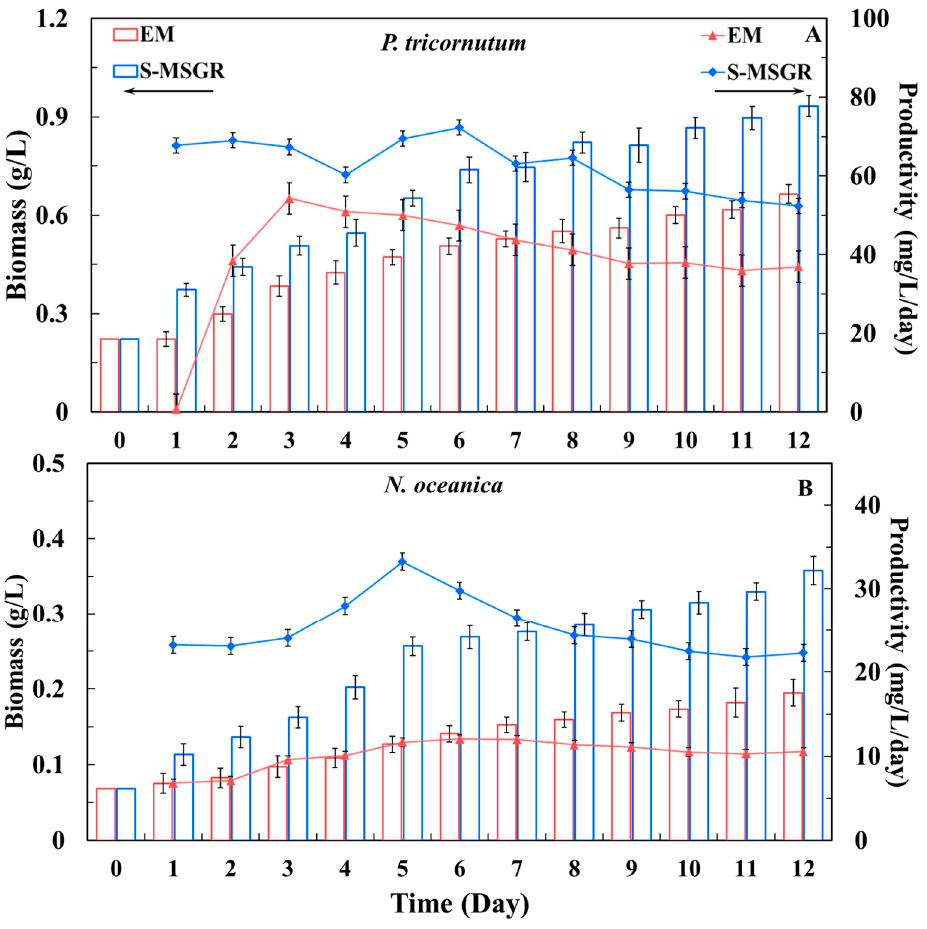
Figure 1. Changes in biomass concentration and the biomass productivity of the two microalgae, P. tricornutum ( A ) and N. oceanica ( B ), in EM and in S-MSGR. Values are expressed as means ± s.d. ( n = 3).